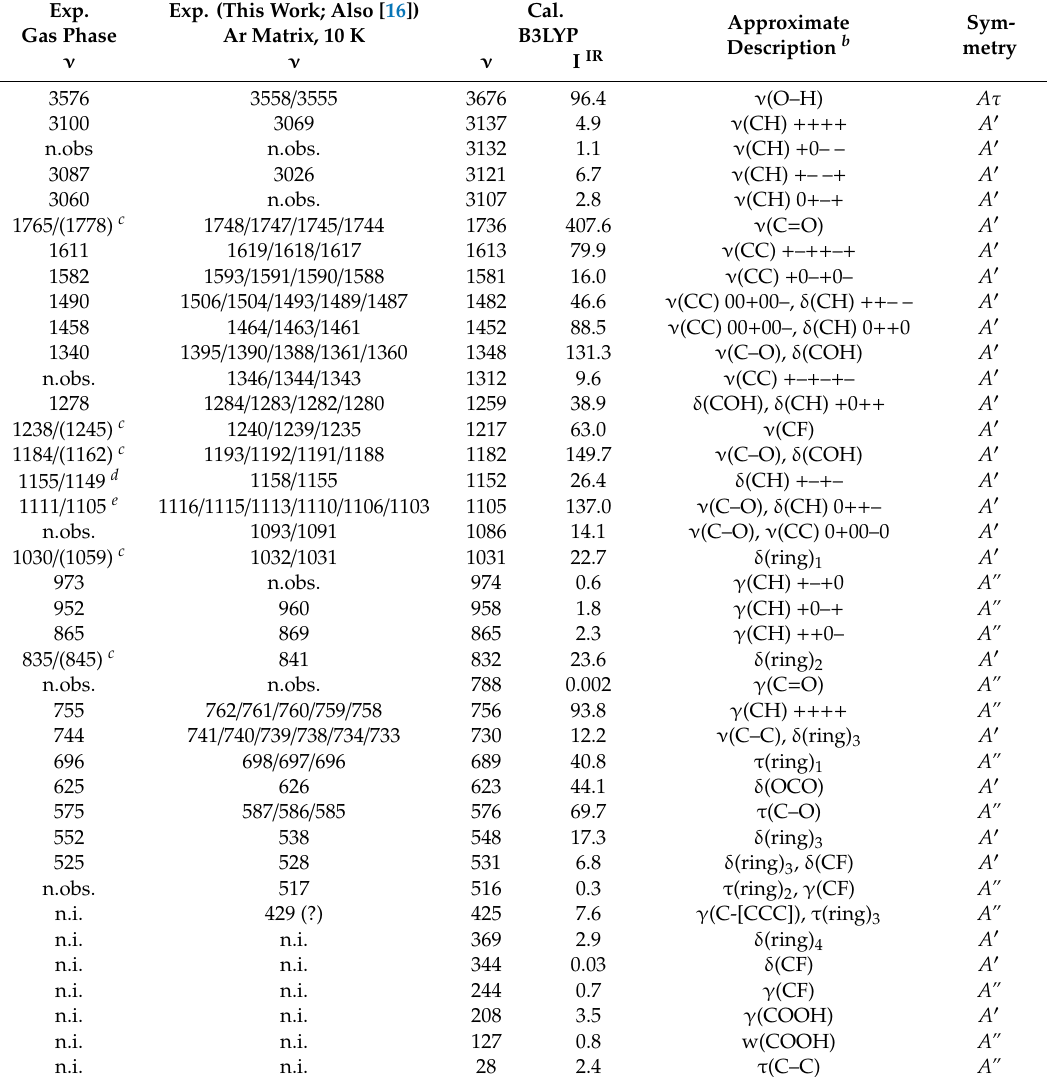
Table 3. Experimental (Exp.) and B3LYP / 6-311 ++ G(d,p) calculated (Calc.; cis -II conformer) infrared spectra of monomeric 2-fluorobenzoic acid, and band assignments a .